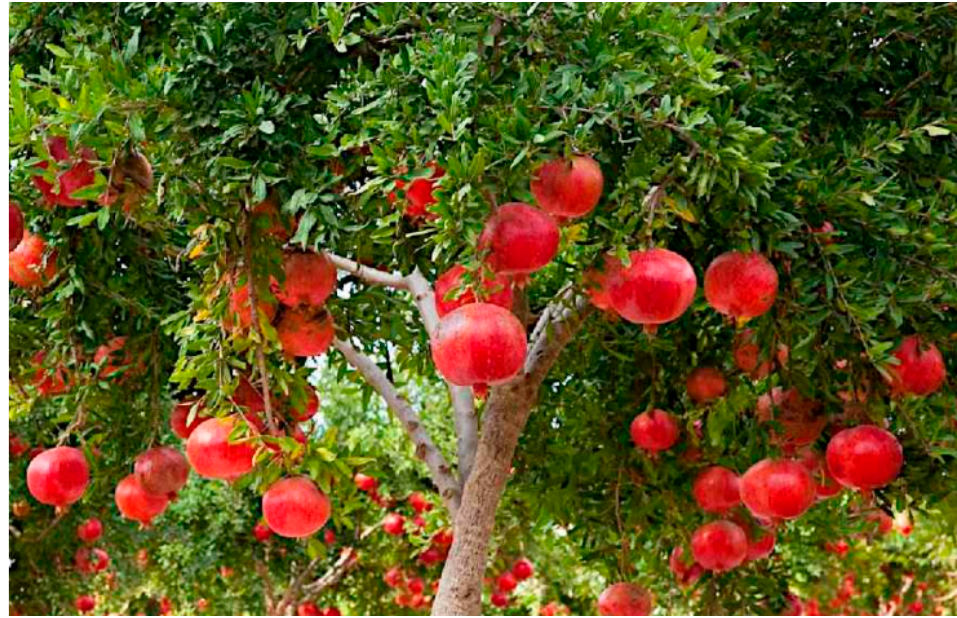
Figure 1. A picture of the P. granatum plant.